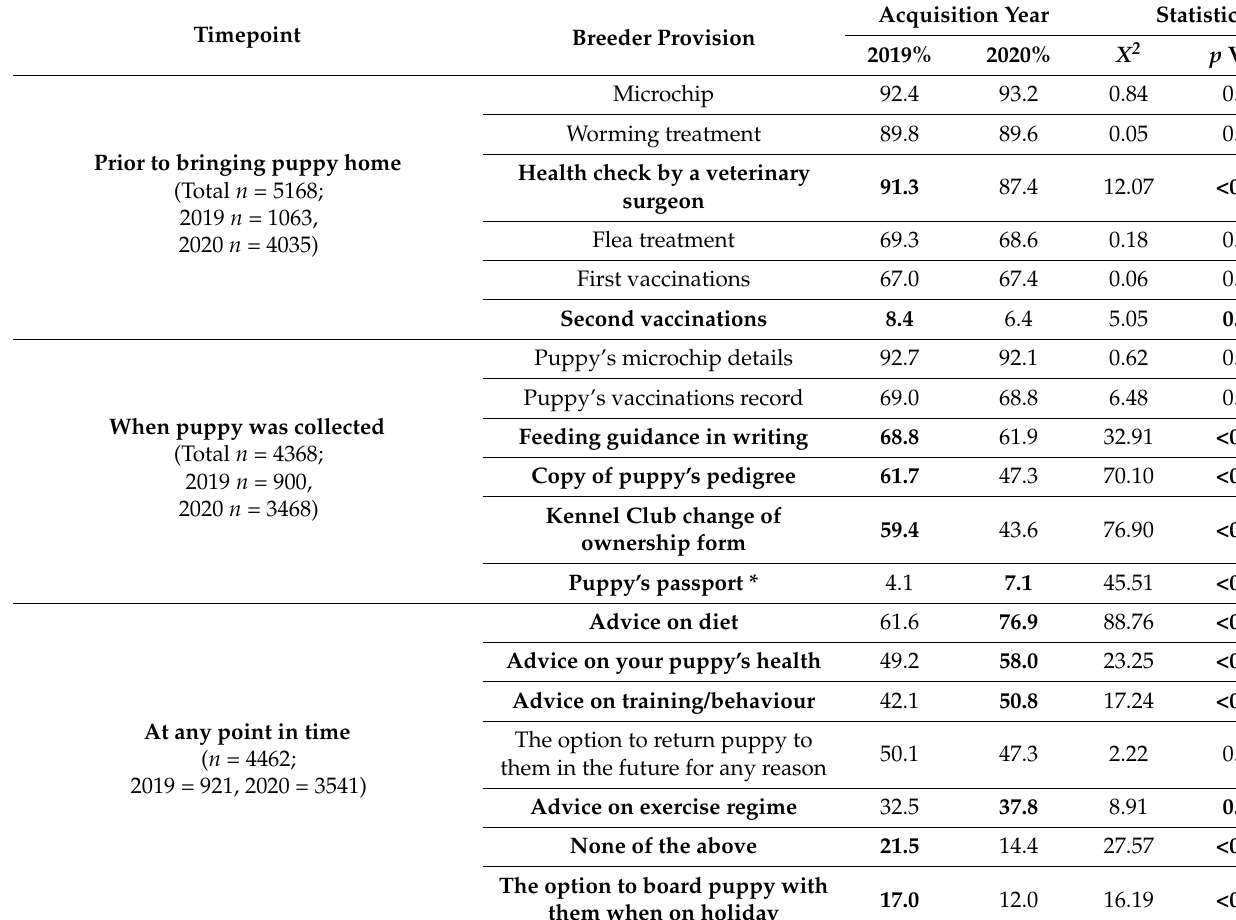
Table 2. Provision of preventative veterinary care, advice and offers of ongoing relationships from breeders to owners of Pandemic Puppies and owners of 2019 puppies (a) prior to taking puppies home; (b) at collection; and (c) at any time point. Significant differences between the two cohorts are emboldened. * Non-commercial Pet Travel Regulations in the UK require puppies to have a Pet Passport and be a minimum of 15 weeks old at importation, for the purposes of rabies control. Acquisition Year Statistics Breeder Provision 2019%